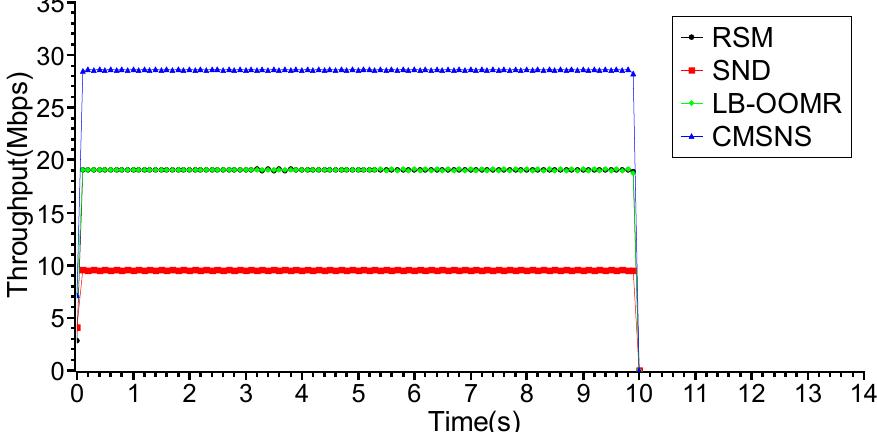
Figure 10. Throughput under Different Node Selection